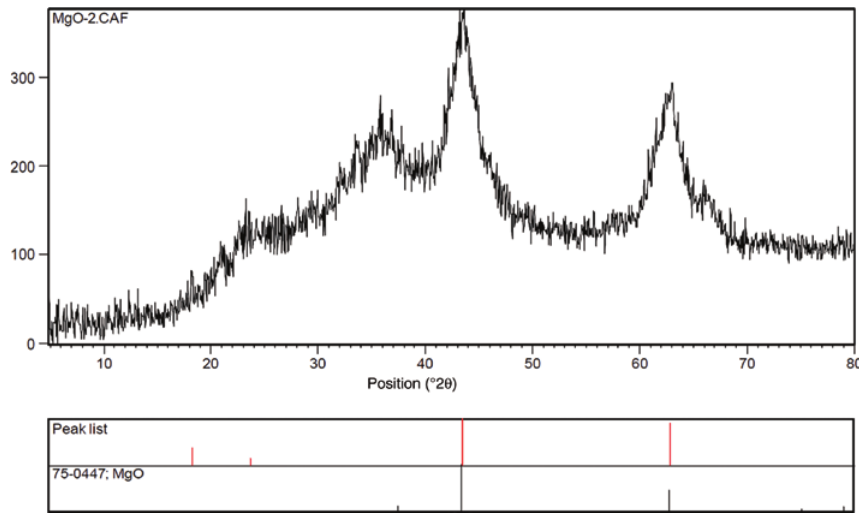
Figure 4: XRD patterns of